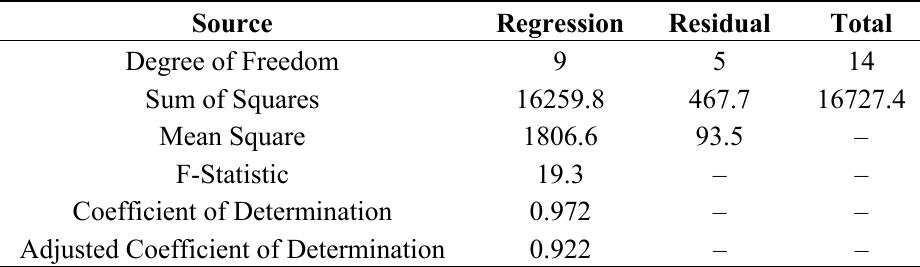
Table 3. Analysis of variance for optimizing rotor